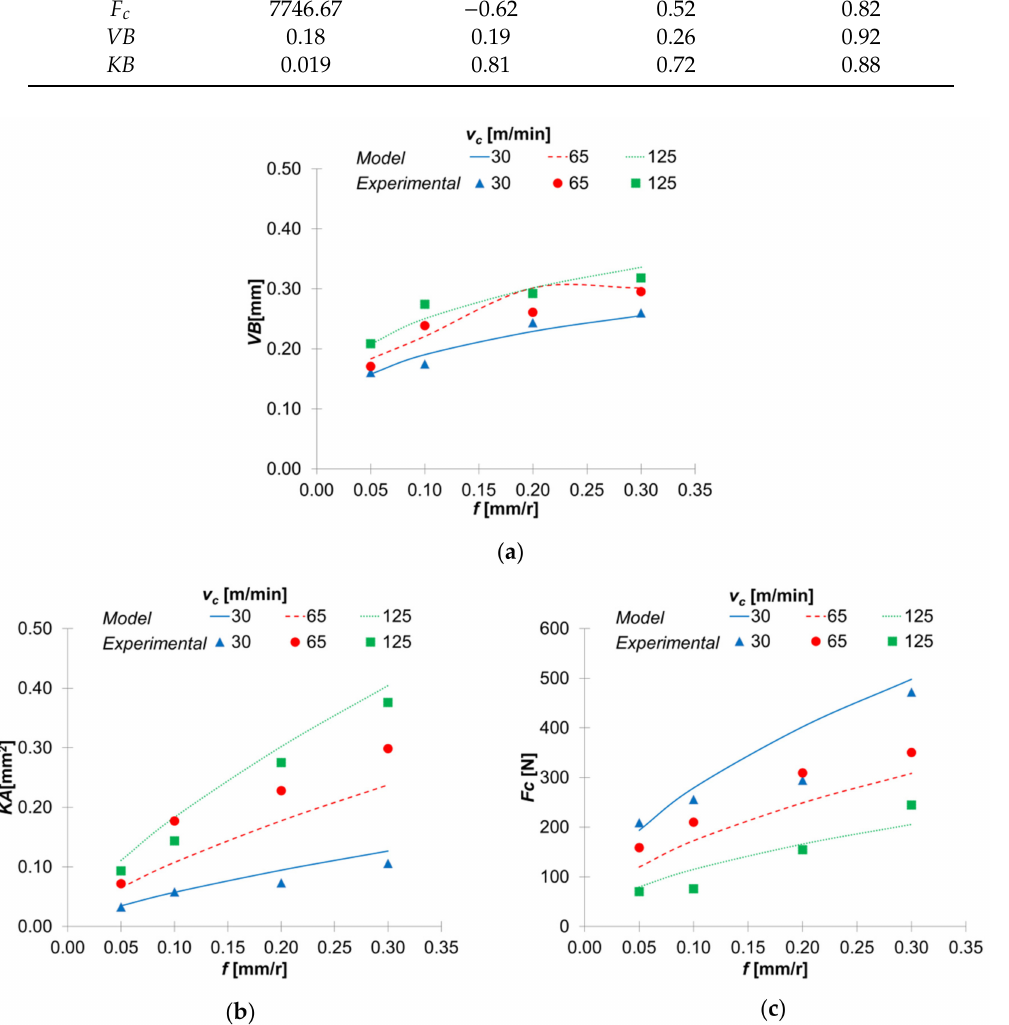
Figure 9. Experimental data vs. parametric models, for ( a ) F c ; ( b ) VB ; and ( c )